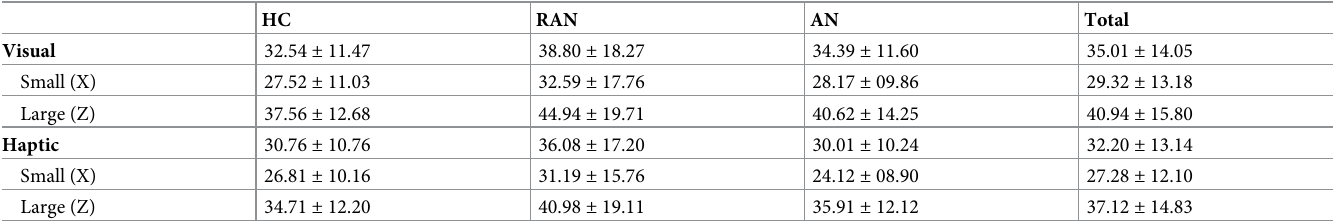
HC ( p = 0.985). This was also evident in the estimations for hips where AN patients made sig- nificantly larger estimations compared to RAN patients ( p = .001, d = 0.9) and HC ( p = .005, d = 0.8). No difference was found between RAN patients and HC ( p = .868). See Table 6 for means and standard deviations. Table 4. Means and standard deviations of grip force peak rate